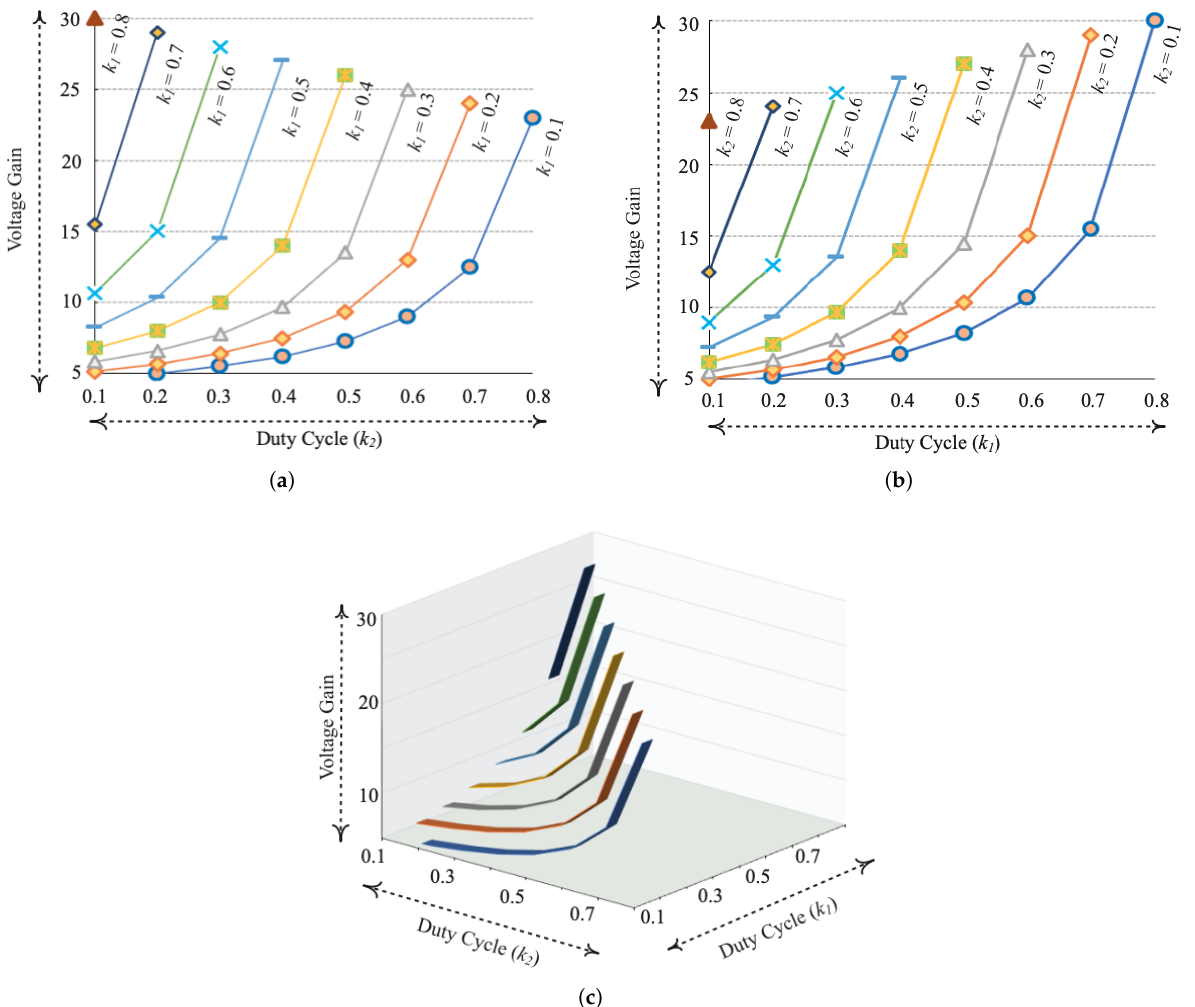
Figure 11. Voltage gain ( a ) versus duty ratio k 2 for different fixed value of duty ratio k 1 , ( b ) versus duty ratio k 1 for different fixed value of duty ratio k 2 , and ( c ) versus duty ratio k 1 and k 2